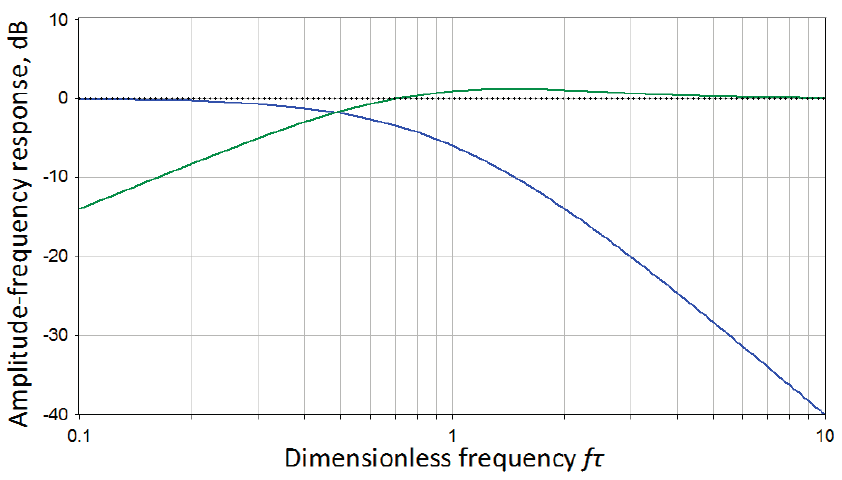
Figure 1. Amplitude-frequency response of transfer functions (2)—blue, (3)—green and their sum—black dotted.